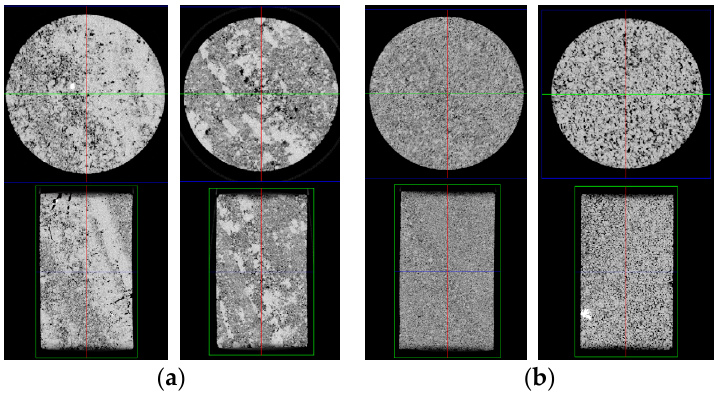
Figure 2. X-ray scans of cores used in the experiments from different production zones: ( a ) Bashkirian stage, ( b ) the Vereian horizon. Black area—voids, gray area—the texture core.